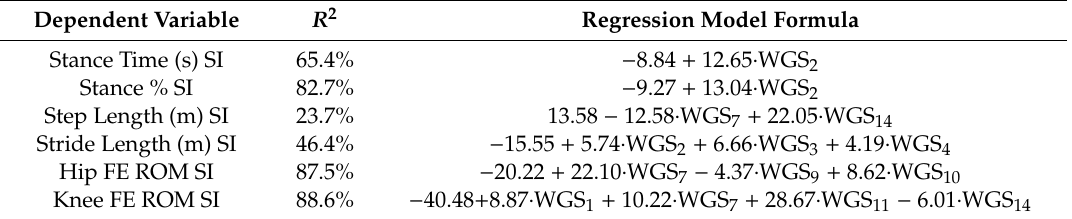
Table 4. Presentation of the regression models describing 3-dimensional (3D) Symmetry Indexes with the use of WGS